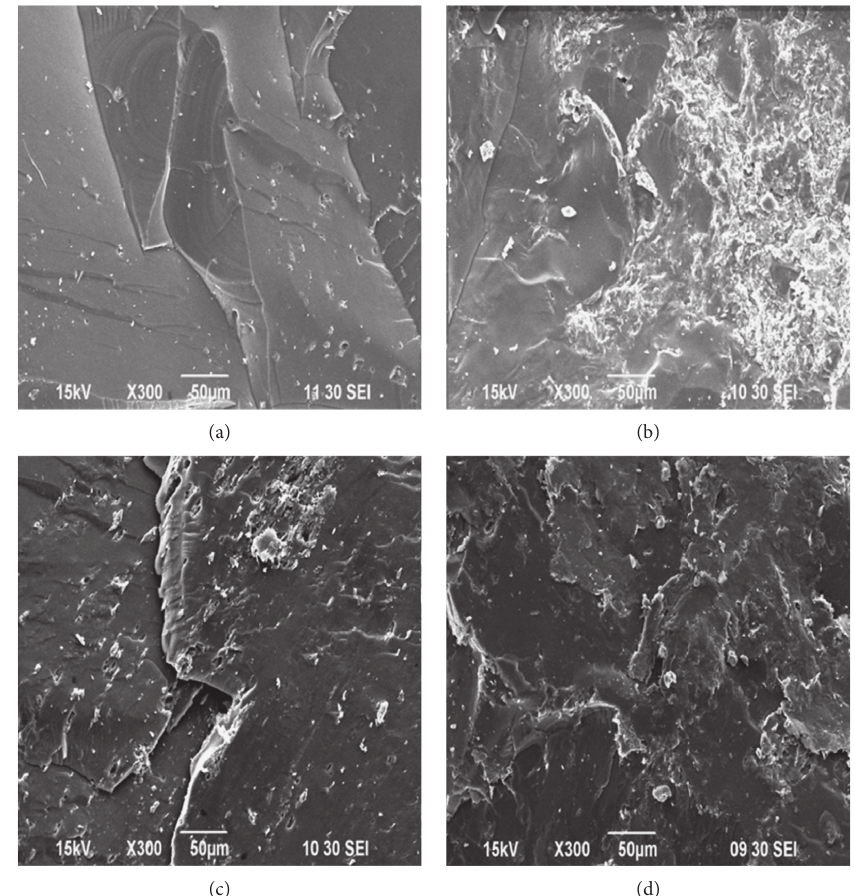
Figure 11: The microscopic structure of coal with different water contents. (a) Dry state. (b) Water content � 1.8%. (c) Water con- tent � 2.5%. (d) Water content � 3.6%.